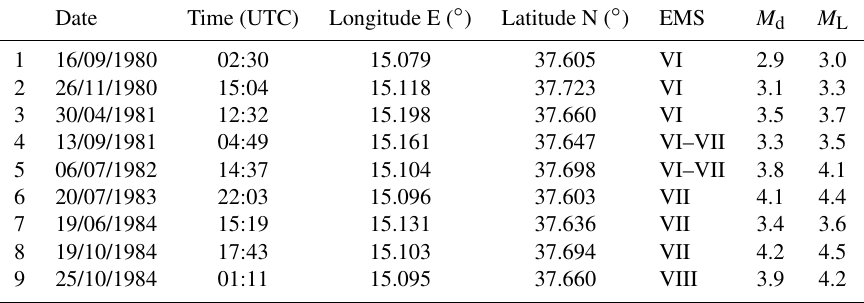
Table 1. List of earthquakes recorded between May 1980 and October 1984 occurred in the investigated area (from Azzaro et al., 2000). Date Time